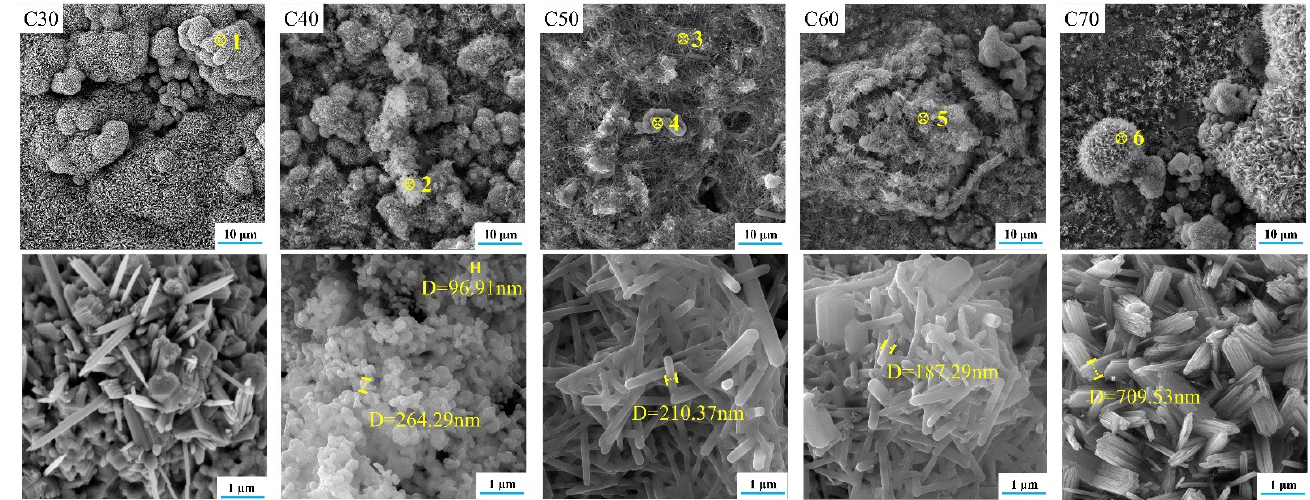
Figure 7. SEM images of the calcination products (C30 − C70).